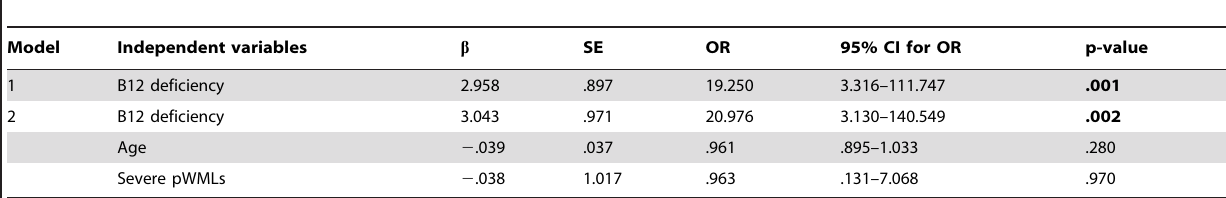
Table 2. Logistic regression analyses on the presence of severe fatigue.